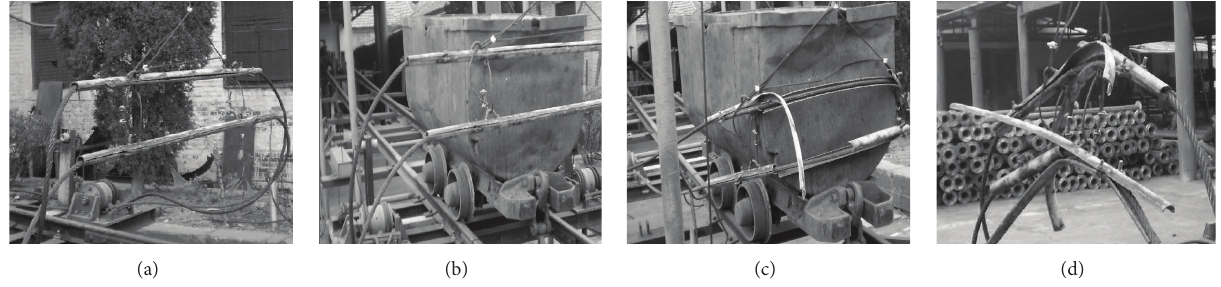
Figure 10: Collision process practicality photo of tramcar-hindering barrier. Table 6: Error analysis of tramcar braking distance.